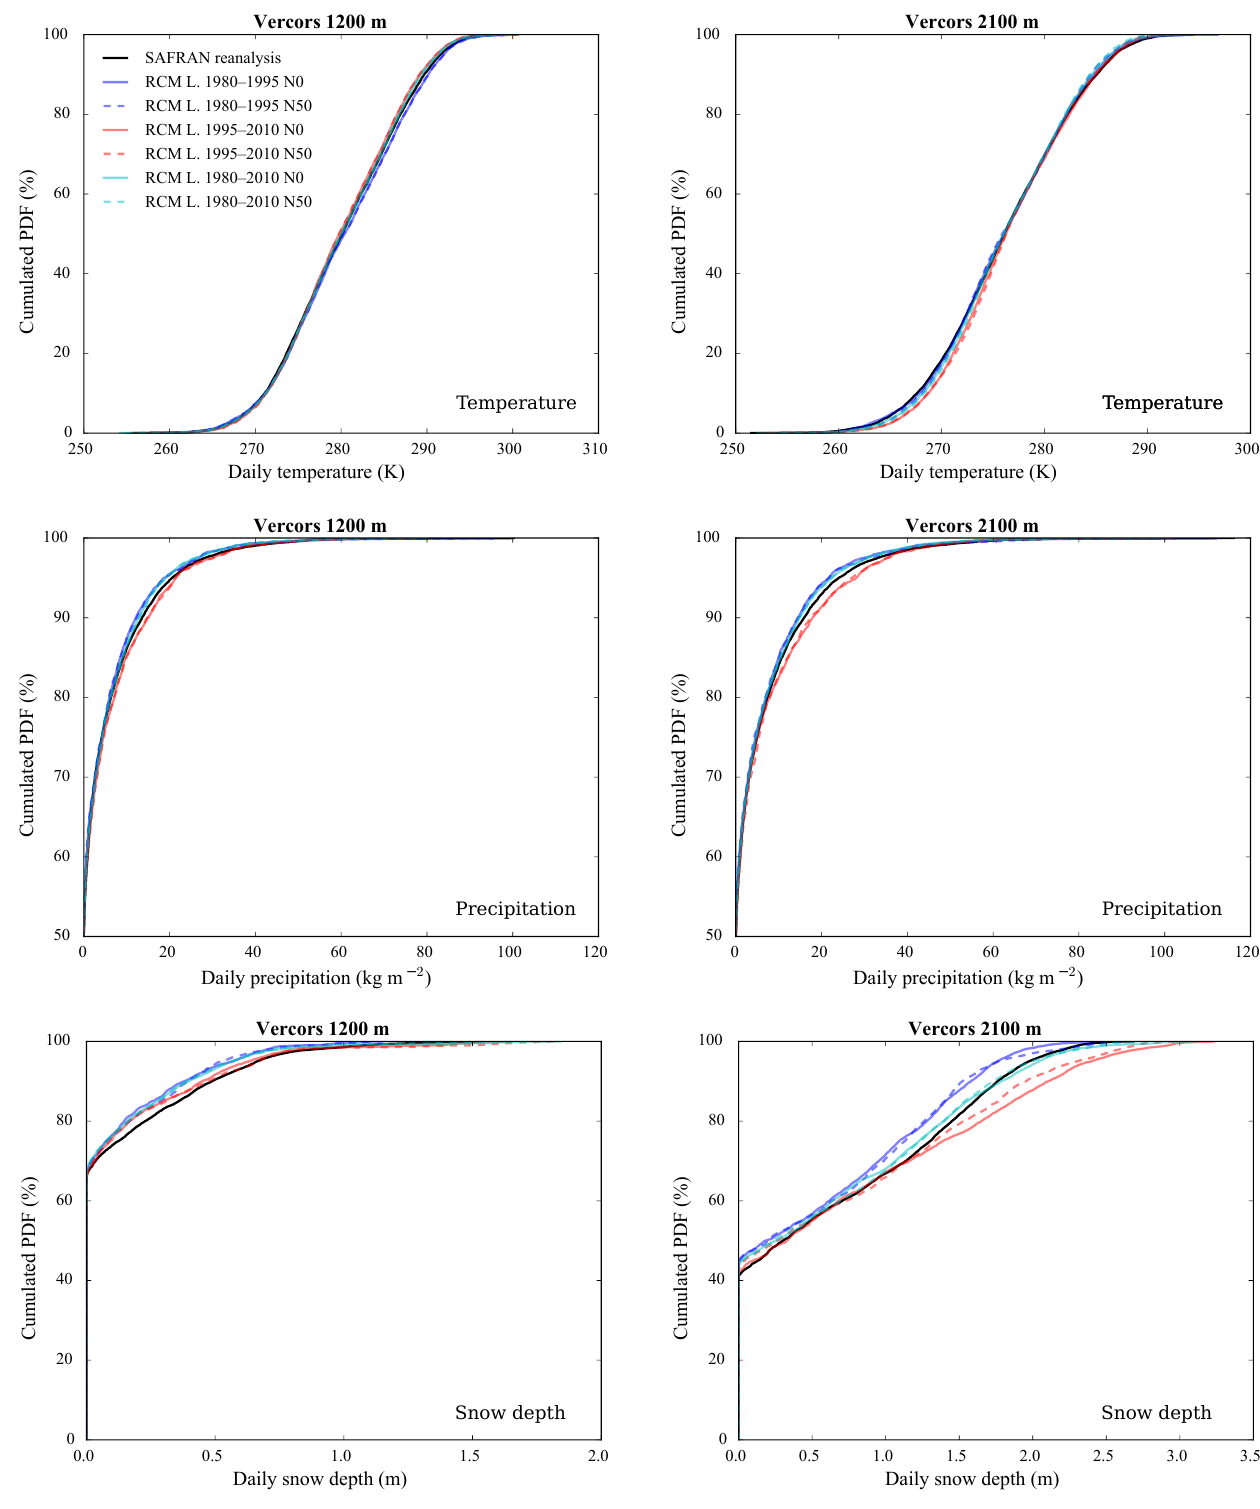
Figure 9. Cumulated probability density function (PDF) of daily temperature, precipitation and snow depth (using Crocus in this case) in each adjusted RCM simulation and in the SAFRAN reanalysis (1980–2010) over the evaluation period for the Vercors massif at 1200 and 2100ma . s . l